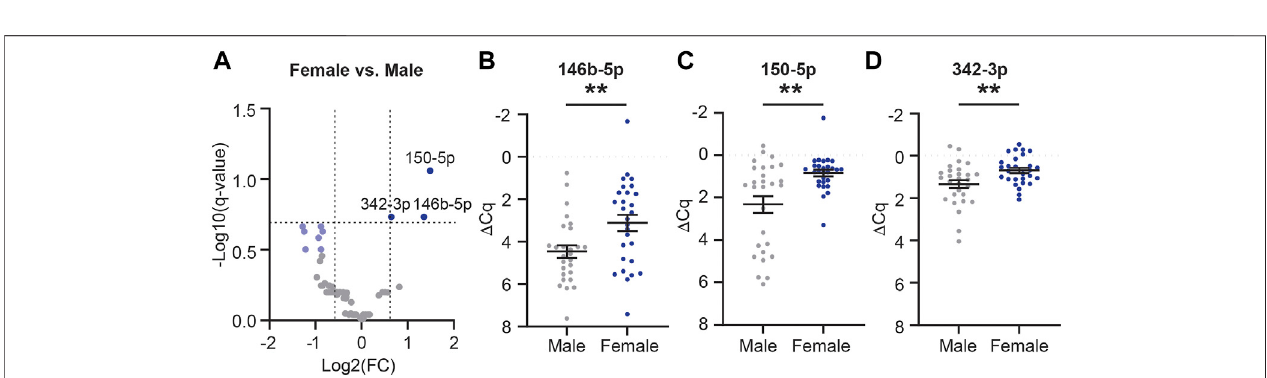
FIGURE 8 | MiRNAs are differentially expressed in female vs. male CSF EVs. (A) Volcano plot shows fold change (FC) of 71 miRNAs expressed in CSF EVs in females(n=28)vs.males(n=28).Theverticaldashedlinescorrespondto1.5FC,andthehorizontaldashedlinedesignatesthecutoffforstatisticallysigni fi cantmiRNAs (Welch ’ s unpaired t -test; p -value < 0.011 based on Benjamini – Hochberg false discovery rate (B-H FDR) 0.20). The miRNAs designated by dark blue circles are signi fi cantlyincreasedbyatleast1.5FCinfemales.MiRNAsinlightbluehavea1.5FCinexpressionwithp-value < 0.05butarebelowtheB-HFDRthreshold. (B – D) Normalized Cq ( Δ Cq) values for the three miRNAs that are signi fi cantly increased in females vs. males. Data shown as the mean ± SEM and analyzed using Welch ’ s unpaired t-tests, ** p < 0.01 and *** p < 0.001.